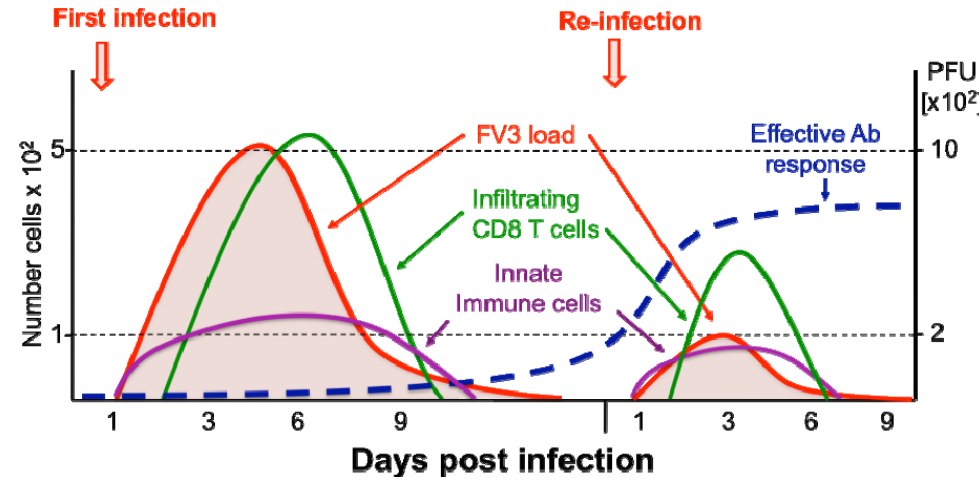
Figure 2. Schematic view of Xenopus adult immune response kinetics in infected kidneys. During both primary and secondary FV3 infections, MHC class II+ innate immune cell effectors (leukocytes) rapidly accumulate in the kidneys (violet line), the main site of infection, and pro-inflammatory genes (e.g., TNF-  , IL-1  ) are induced. This is followed by an adaptive CD8 T cell response and infiltration (green line) that peak at 6 dpi during a primary infection. During a second FV3 infection, CD8 T cell response and infiltration peak 3 days earlier, which suggests T cell memory. However, the lower number of infiltrated CD8 T cells (5 time less) suggests that anti-FV3 antibodies (blue line) and B cell memory are playing a prominent role during secondary infection resulting in a faster viral clearance (red